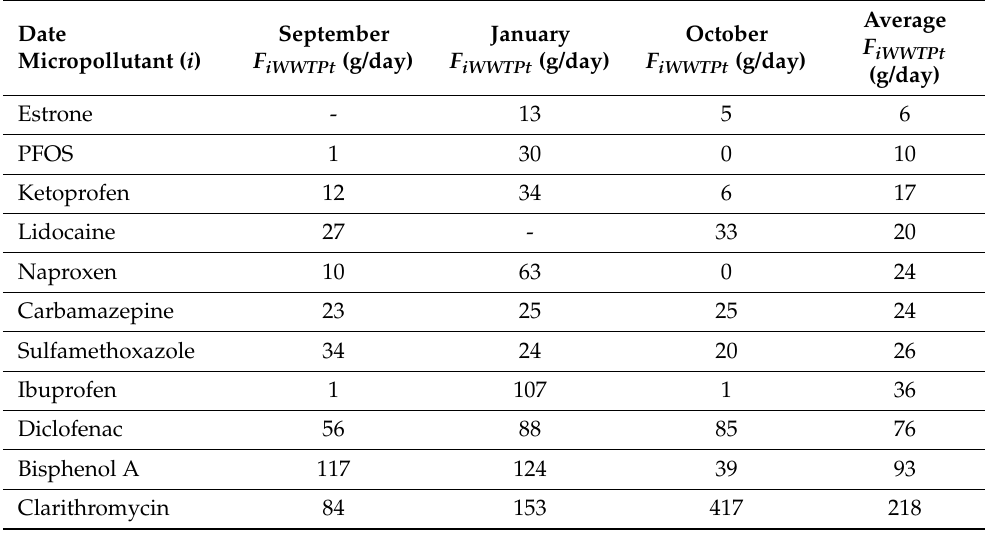
Table 5. The outgoing mass flux of micropollutants from the WWTP ( F iWWTPt ) of the quantified micropollutants during the three sampling periods. The average F iWWTPt is the average of the three values of the mass fluxes. The components are ranked in ascending order of average F iWWTPt . A dash ‘-’ is used when C it at the sites studied are <